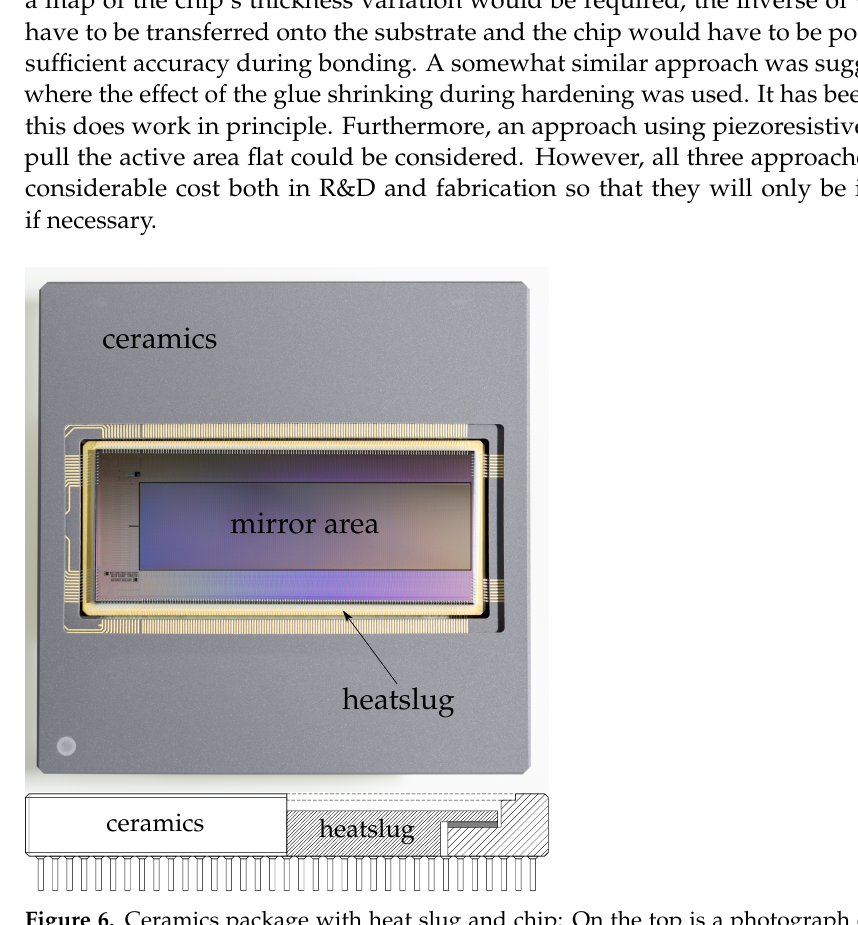
Figure 6. Ceramics package with heat slug and chip: On the top is a photograph of the package with the chip, and on the bottom is a drawing of a horizontal cross-section through the center of the package (without the